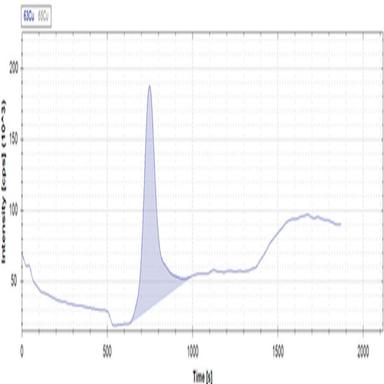
WP formulation: Copper (Cu) by ICP-MS in 1st fraction eluted by AF4-FFF-MALS.